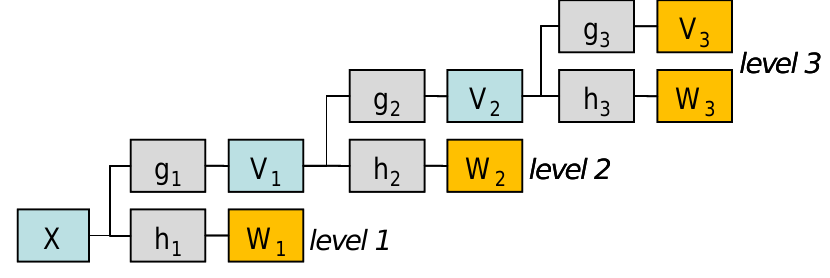
Figure 3. MODWT cascade algorithm. X is the analysed signal, g (low-pass) and wavelet (high-pass) filters respectively, v detail MODWT coefficients of the i -th level of decomposition respectively.